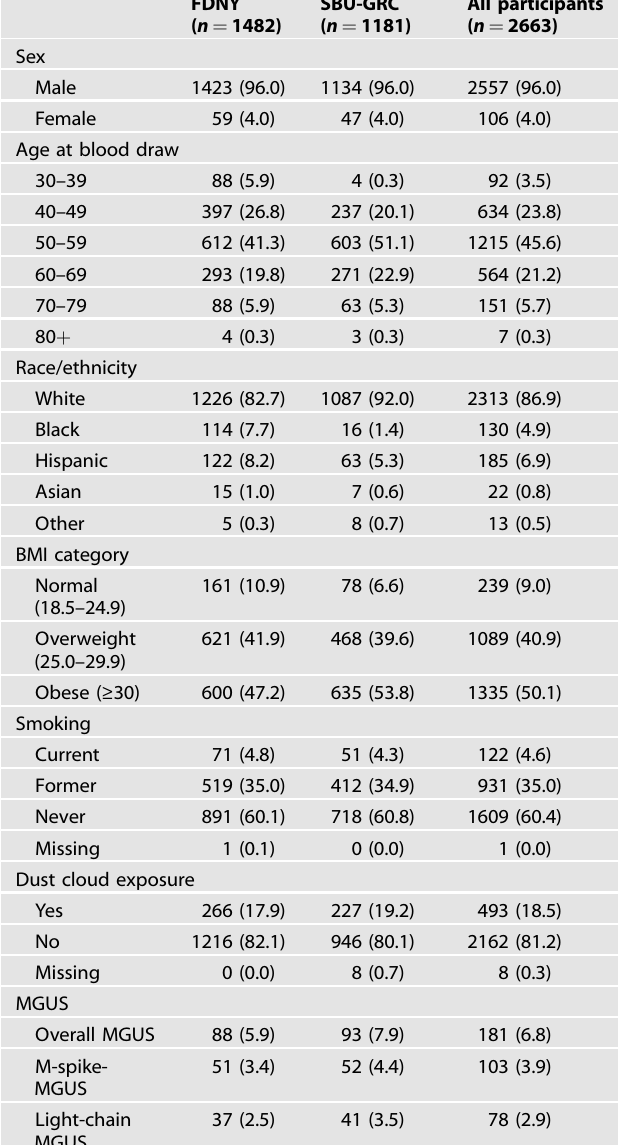
Table 1. Selected characteristics by